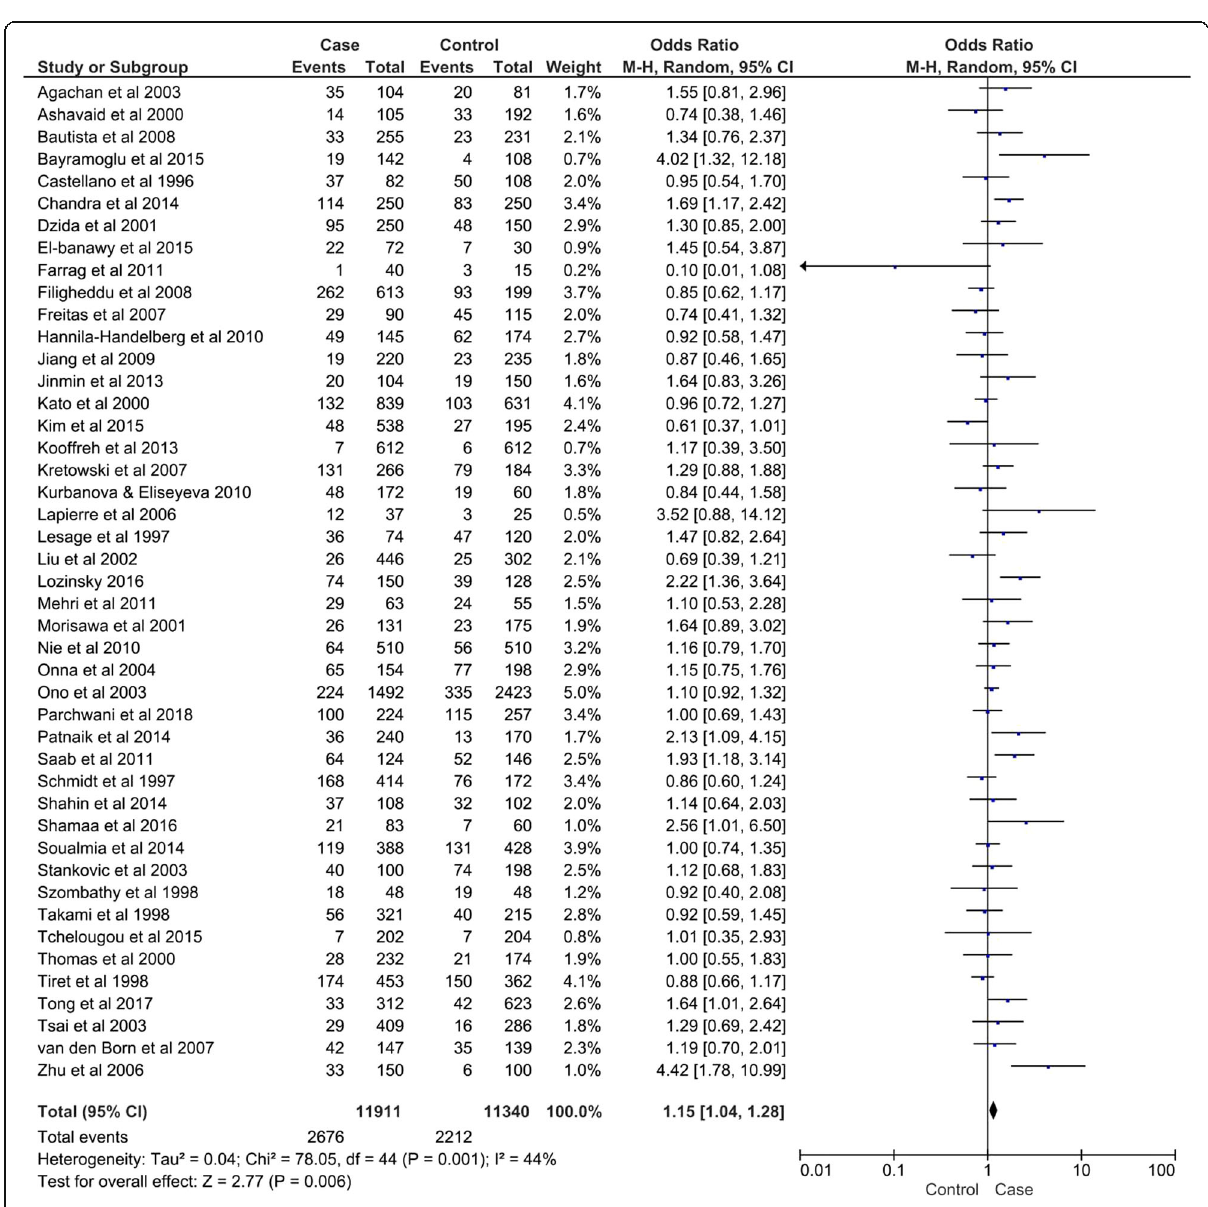
Fig. 3 The association between AT1R A1166C gene polymorphism and the risk of essential hypertension (AC vs. AA +